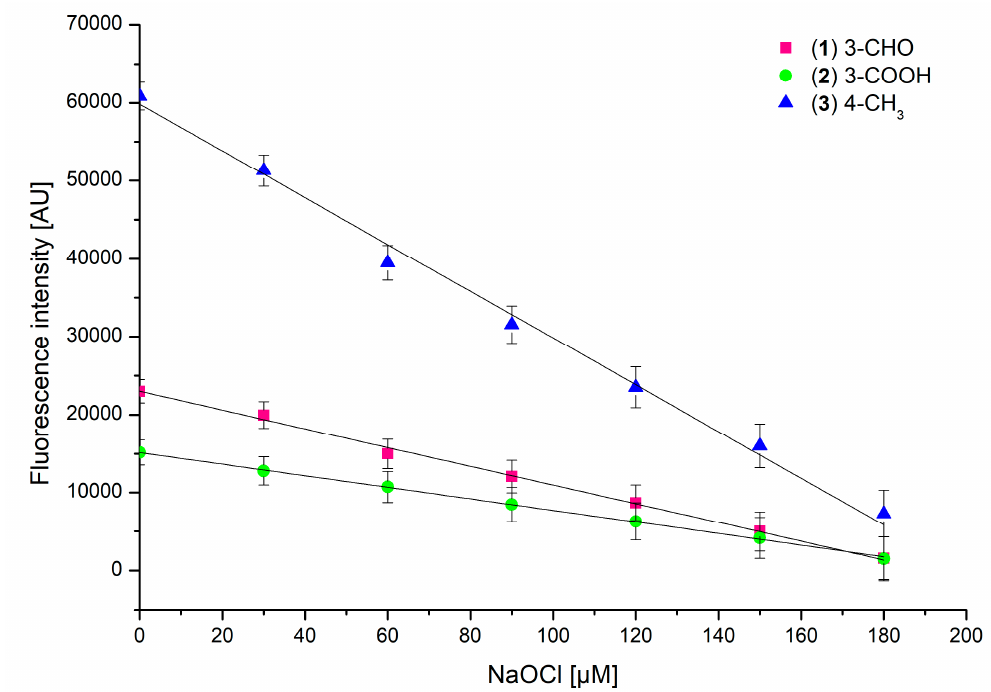
Figure 2. Changes in fluorescence intensity of 150 µ M of 1 – 3 induced by an increase in NaOCl concentration, at pH 5, λ Ex 289 nm ( λ Em 464 nm, 460 nm, and 450 nm, respectively), and a temperature of 25 °C.